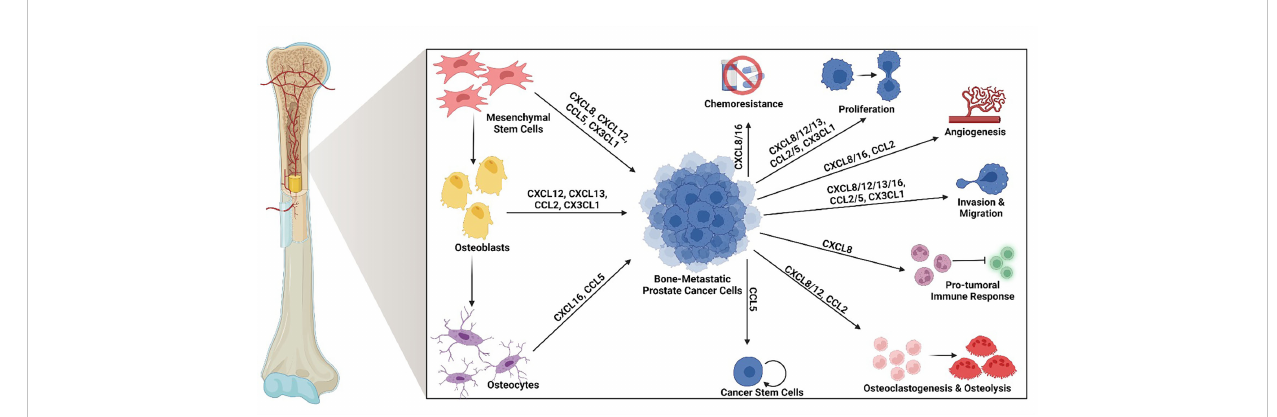
FIGURE 1 Osteoid cell-derived chemokines and their roles in bone-metastatic prostate cancer. Many chemokines produced by osteoid cells in the bone promote bone-metastatic prostate cancer progression. Speci fi cally, mesenchymal stem cells produce CXCL8, CXCL12, CCL5, and CX3CL1; osteoblasts produce CXCL12, CXCL13, CCL2, and CX3CL1, and osteocytes produce CXCL16 and CCL5. Among these, CXCL8 and CXCL16 have been found to promote chemoresistance. CXCL8, CXCL12, CXCL13, CCL2, CCL5 and CX3CL1 enhance tumor cell proliferation. CXCL8, CXCL16, and CCL2 contribute tumor-induced angiogenesis. CXCL8, CXCL12, CXCL13, CXCL16, CCL2, CCL5, and CX3CL1 induce tumor cell migration and invasion. CXCL8 drives a pro-tumoral immune response, often involving myeloid cell suppression of anti-tumor effector cells. CXCL8, CXCL12, and CCL2 induce osteoclastogenesis and tumor-induced osteolysis. CCL5 increases the population of cancer stem cells. Created by